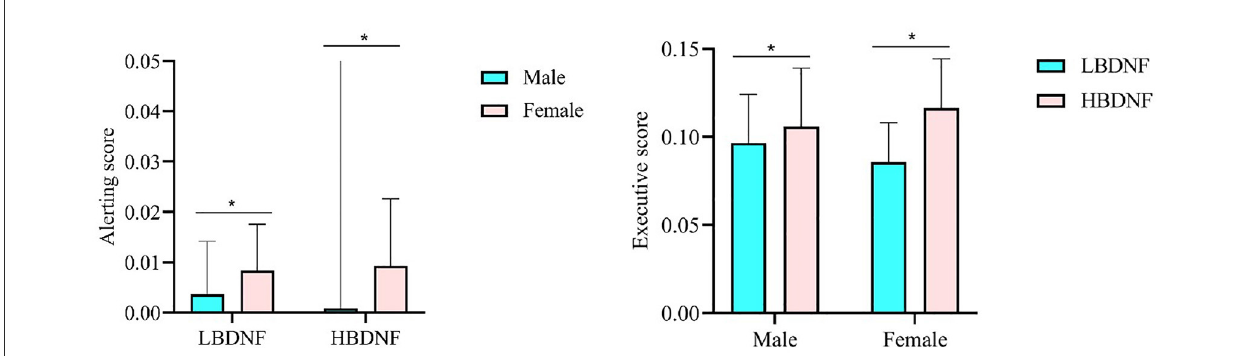
FIGURE6 The gender effect in alerting and the BDNF effect in executive control. * p < 0.05. BNDF, brain-derived neurotrophic factor.